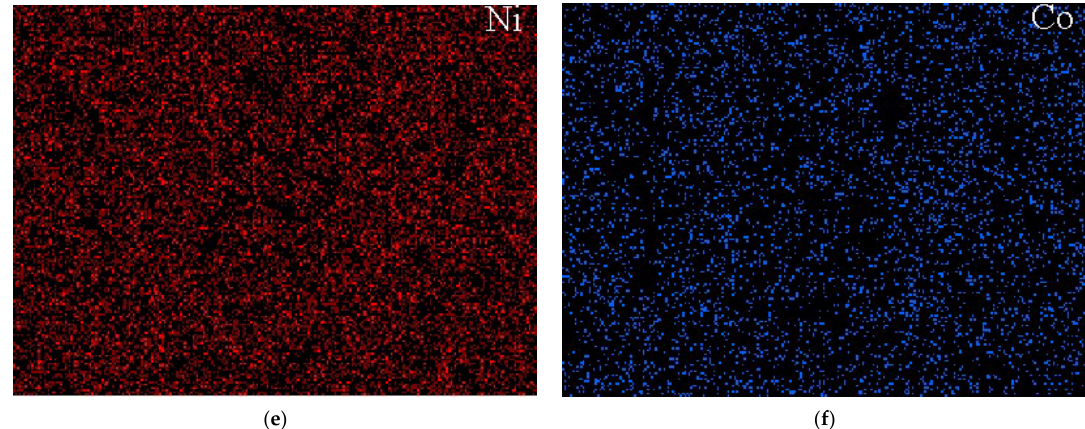
Figure 6. EDX maps of elements in the middle part of the CoCrFeNiMn coating prepared at 70 A plasma arc current: ( a ) microstructure; ( b ) Cr distribution; ( c ) Mn distribution; ( d ) Fe distribution; ( e ) Ni distribution; ( f ) Co distribution .